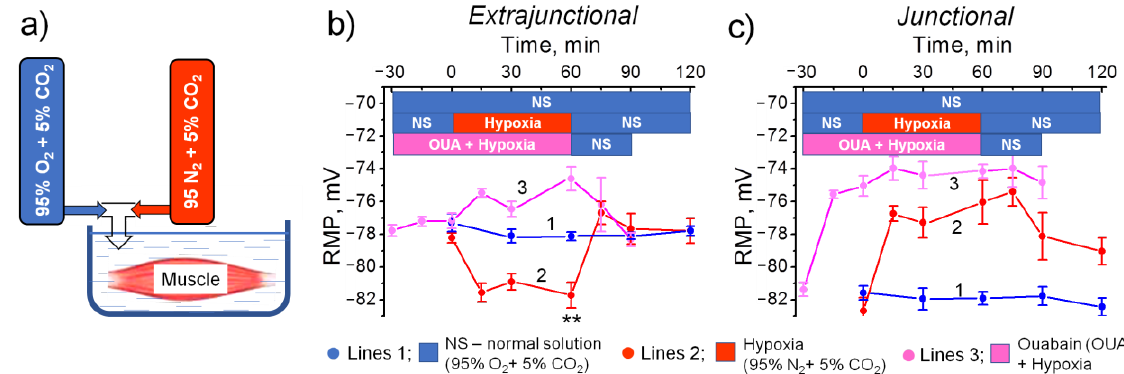
Figure 5. ( a ) The study outline. Acute effects of hypoxia on the RMP at the extrajunctional ( b ) and junctional ( c ) membrane regions of the isolated rat diaphragm muscle. The RMP dynamics of muscles perfused with different solutions are shown. The muscles were exposed to 60 min hypoxia (95 N 2 + 5% CO 2 ) followed by 60 min reoxygenation in the normal physiological solution (NS, 95% O 2 + 5% CO 2 ). In the control muscles, RMPs were recorded in the normal solution within 120 min. Ouabain (50 nM) incubation was started 30 min prior to adding the hypoxic solution. Each data point corresponds to the averaged RMP measured in 5 – 7 muscles. One-way ANOVA followed by Bonferroni multiple comparisons test. ** p < 0.01 — compared to the corresponding control point.